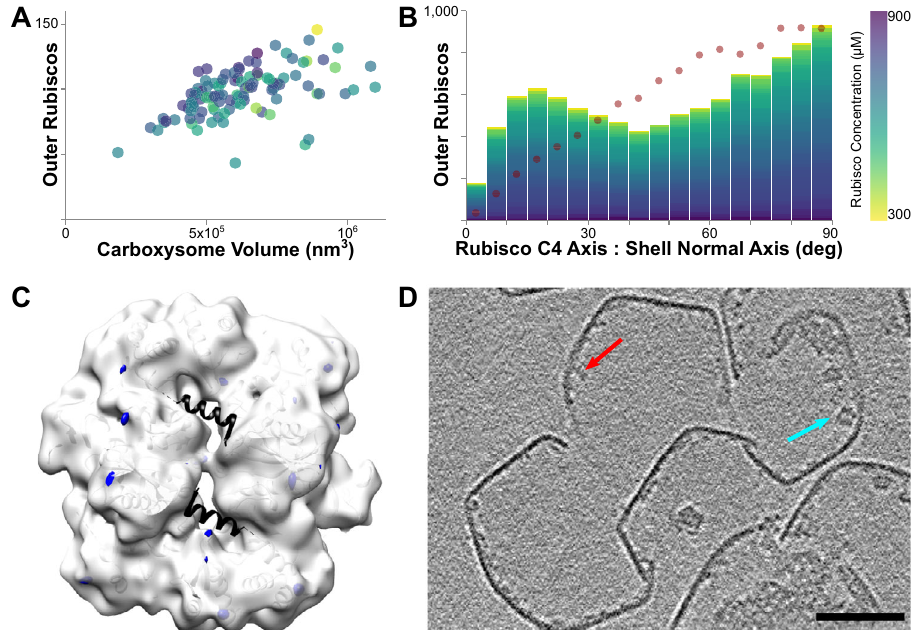
Fig.5|Rubiscointheouterlayeradjacenttotheshell.A Rubiscolinestheshellin avolume-dependentbutconcentration-independentmanner. B Ahistogramofthe anglebetweentheRubiscoC4axisandthenormalaxisoftheadjacentshellshowsa modest preference for perpendicular orientations. Dotted line indicates random orientation. C We do not observe strong CsoS2 occupancy in the outer Rubisco